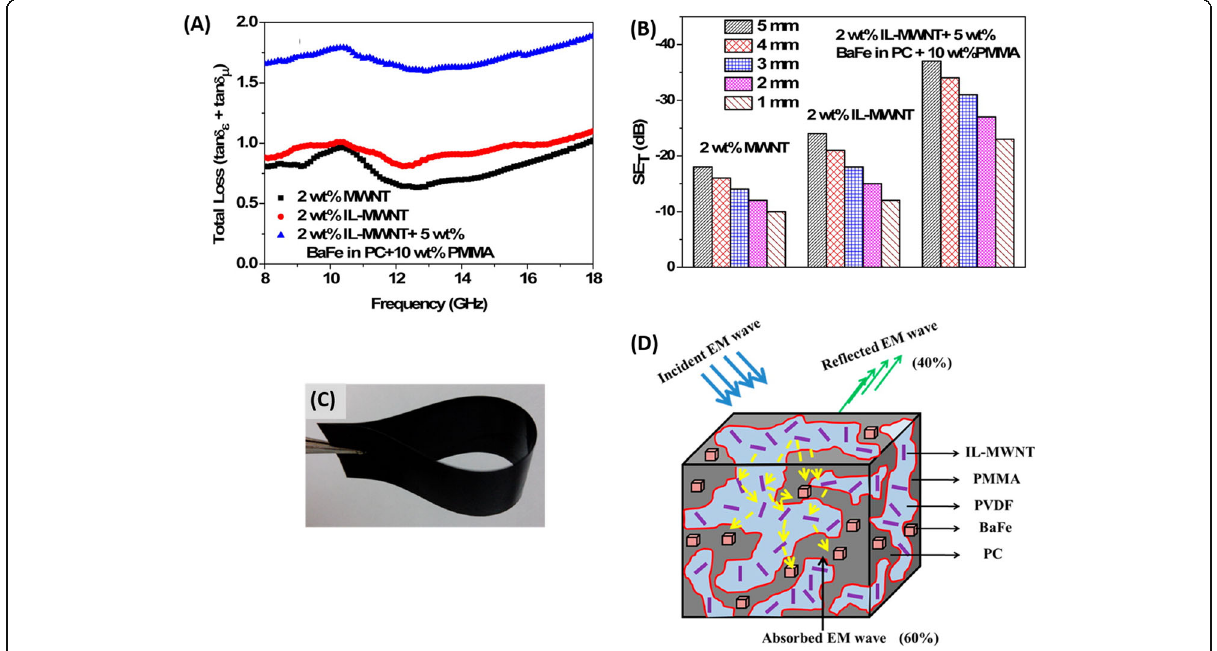
Fig. 15 (A) Total loss tangent for various blends as a function of frequency; ( B ) SE T with respect to thickness; ( C ) The obtained flexible film; ( D ) Cartoon representing the mechanism of EM attenuation for blends containing 2 wt% IL-MWNT in PVDF phase and 5 wt% BaFe in the PC